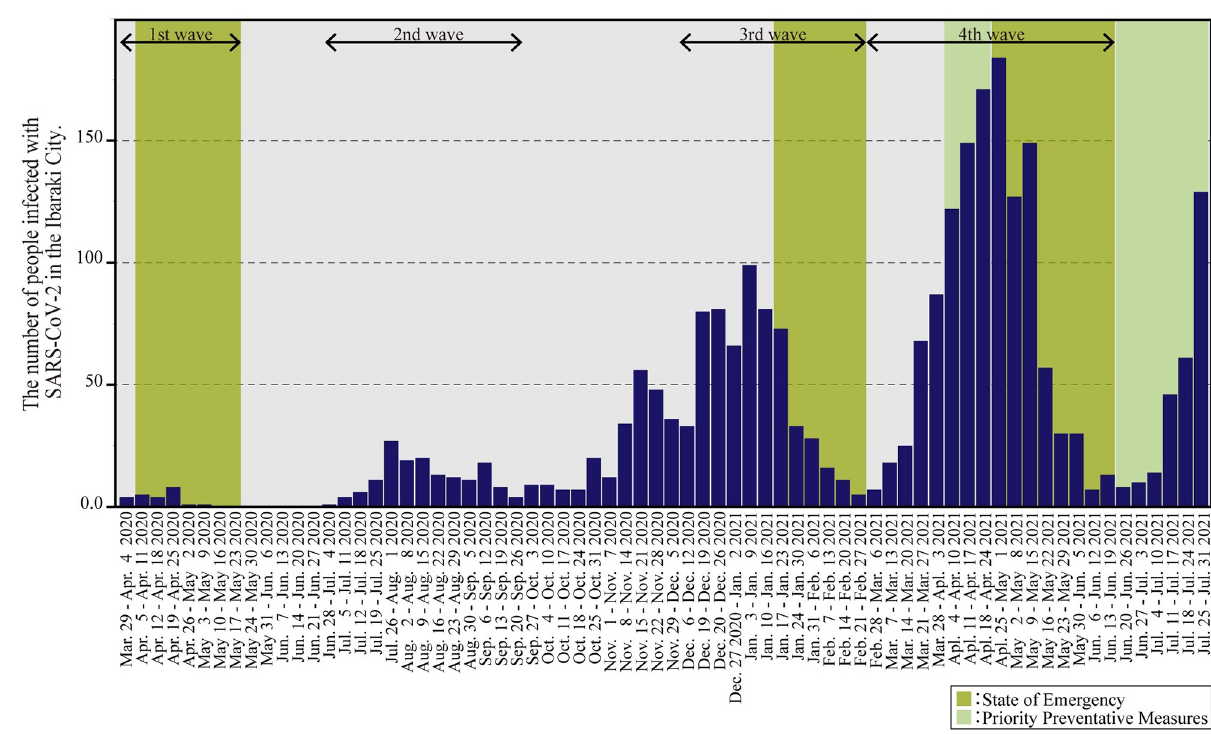
Fig 5. Weekly change of the number of infected people between March 29, 2020, and July 31, 2021. Osaka Prefecture experienced four waves during this time. Green periods are during the state of emergency, and yellow-green periods are during the priority prevention measures.